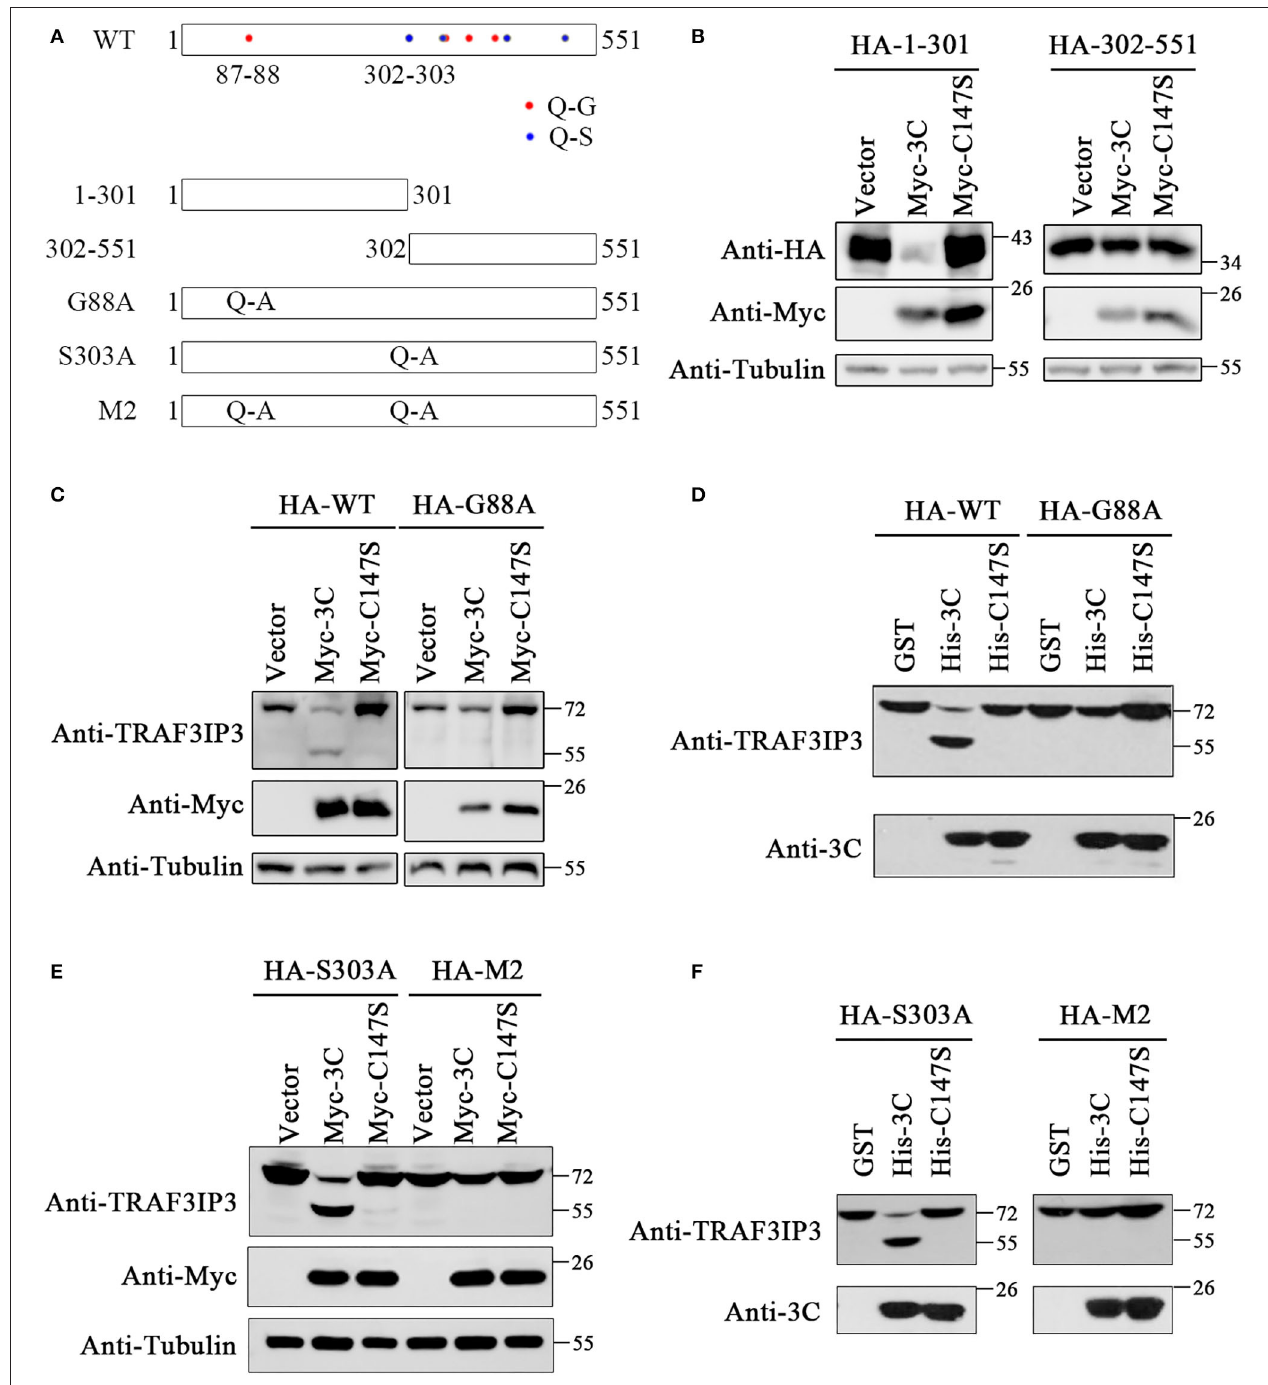
FIGURE 3 | The 87Q-88G is the only site in TRAF3IP3 that is cleaved by 3C pro . (A) Schematic representation of the potential 3C pro cleavage sites in TRAF3IP3. (B) HEK293T cells were transfected with HA-TRAF3IP3 1–301 or 302–551 and Myc-3C. Forty-eight hours later, Western blotting was used to detect the proteins. (C) HA-TRAF3IP3 wild-type or G88A mutant was co-transfected with Myc-3C or mutant C147S into HEK293T cells. Cells were harvested 48h after transfection for Western blotting analysis. (D) HEK293T cells were transfected with HA-TRAF3IP3 wild-type or G88A mutant. Cells were harvested 48h after transfection and lysates were incubated with purified 3C pro or mutant 3C-C147S for 90min at 30 ◦ C. Loading buffer was added to stop the reaction, followed by Western blotting detection of proteins. (E) HA-TRAF3IP3 single-mutant S303A or double-mutant G88A S303A (M2) were co-transfected with Myc-3C or mutant C147S into HEK293T cells. Cells were harvested 48h after transfection for Western blotting. (F) HA-TRAF3IP3-S303A or M2 was transfected into HEK293T cells. The rest of the experiment was the same as the in vitro cleavage in (D) .